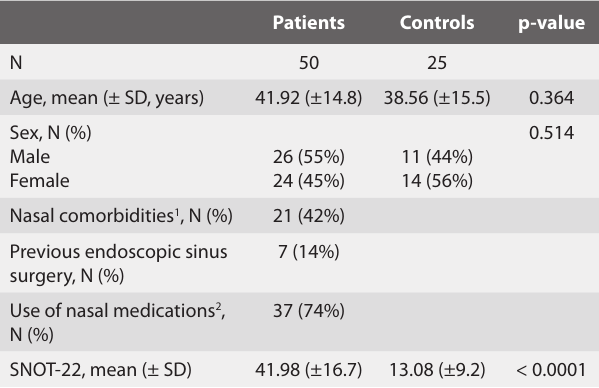
Table 1. Clinical and demographic data for all